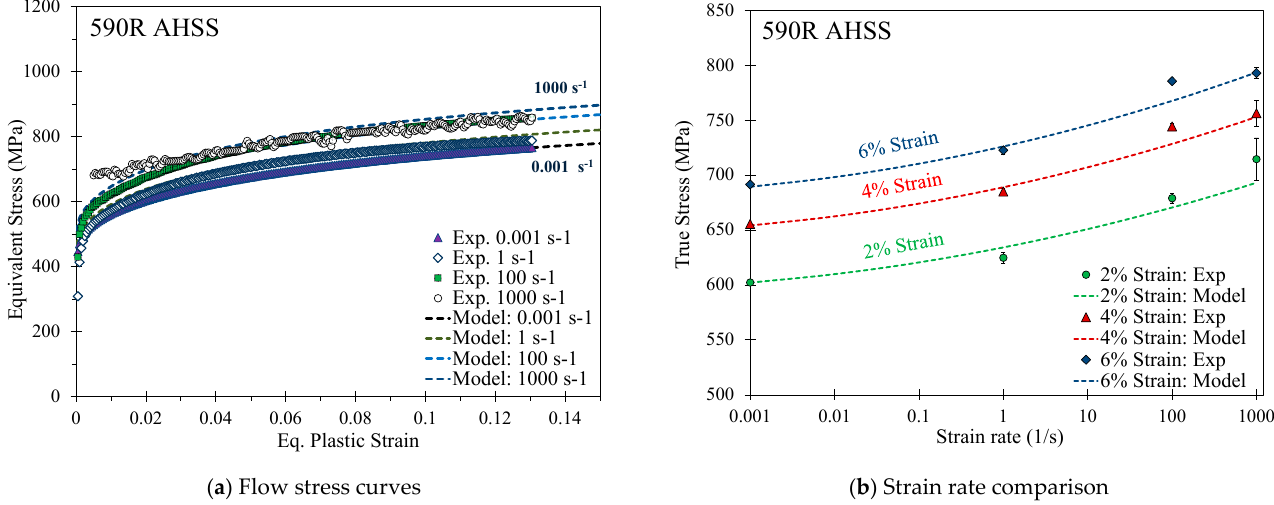
Figure 10. Calibrated quadratic Johnson Cook rate-dependent constitutive model for the 590R AHSS.